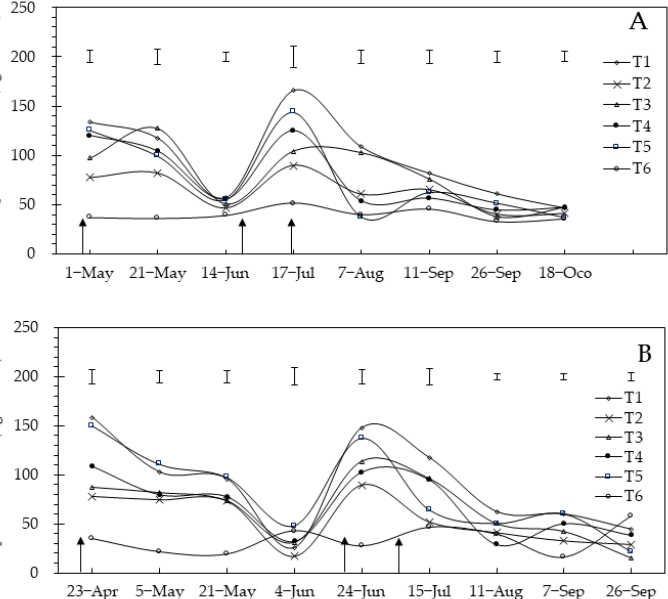
Figure 4. A and B represent the years 2020 and 2021 respectively. The dynamic changes of nitrous oxide emissions during the entire growth period of maize. The vertical bars represent the least significant difference (LSD) at p < 0.05. Arrows represent fertilization. T1: inorganic fertilizer; T2: 50.0% organic fertilizer; T3: 37.5% organic fertilizer; T4: 25.0% organic fertilizer; T5: 12.5% organic fertilizer; T6: no fertilizer.